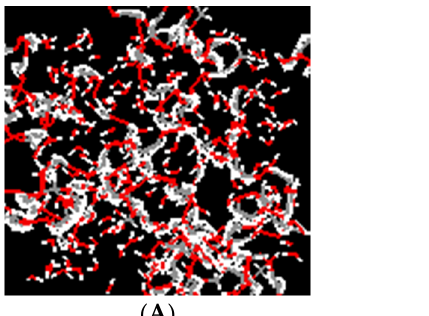
( B ) Figure 14. The 3D structures of the superimposed ATP and TPGS in complex with P ‐ gp. ( A ) shows the location of the binding site (NBD) of ATP and TPGS (circled). ( B ) displays the superimposed ligands with ATP (red) confined into the deep binding cavity while TPGS (green), due to its poly ‐ meric nature, protrudes to the outside allosteric binding pocket with its hydrophobic α‐ tocopherol chain. Consistent with the data reported by Liu et al. [51], TPGS interacted tightly with the binding site through its hydrophilic PEG tail. In this study, TPGS formed two hydrogen bonds with Arg 538 and Ser 1071 (PEG region) and was stabilized in position to assume the optimum crystal pose by Pi ‐ interaction with Lys 515 and its aromatic ring that forms part of the α‐ tocopherol, with a docking score of − 7.849 (Figure 15A). The succinate portion that links PEG to the α‐ tocopherol played a great role in enforcing the required confor ‐ mation for aromatic ring stabilization. The lipophilic α‐ tocopherol was involved in hydro ‐ phobic interactions with various amino acid residues, including Gln 1081 , Tyr 1086 , Thr 1078 , Arg 262 , Asp 805 , and Ala 529 (Figure 15B). Additionally, this hydrophobic chain (Figure 14B,